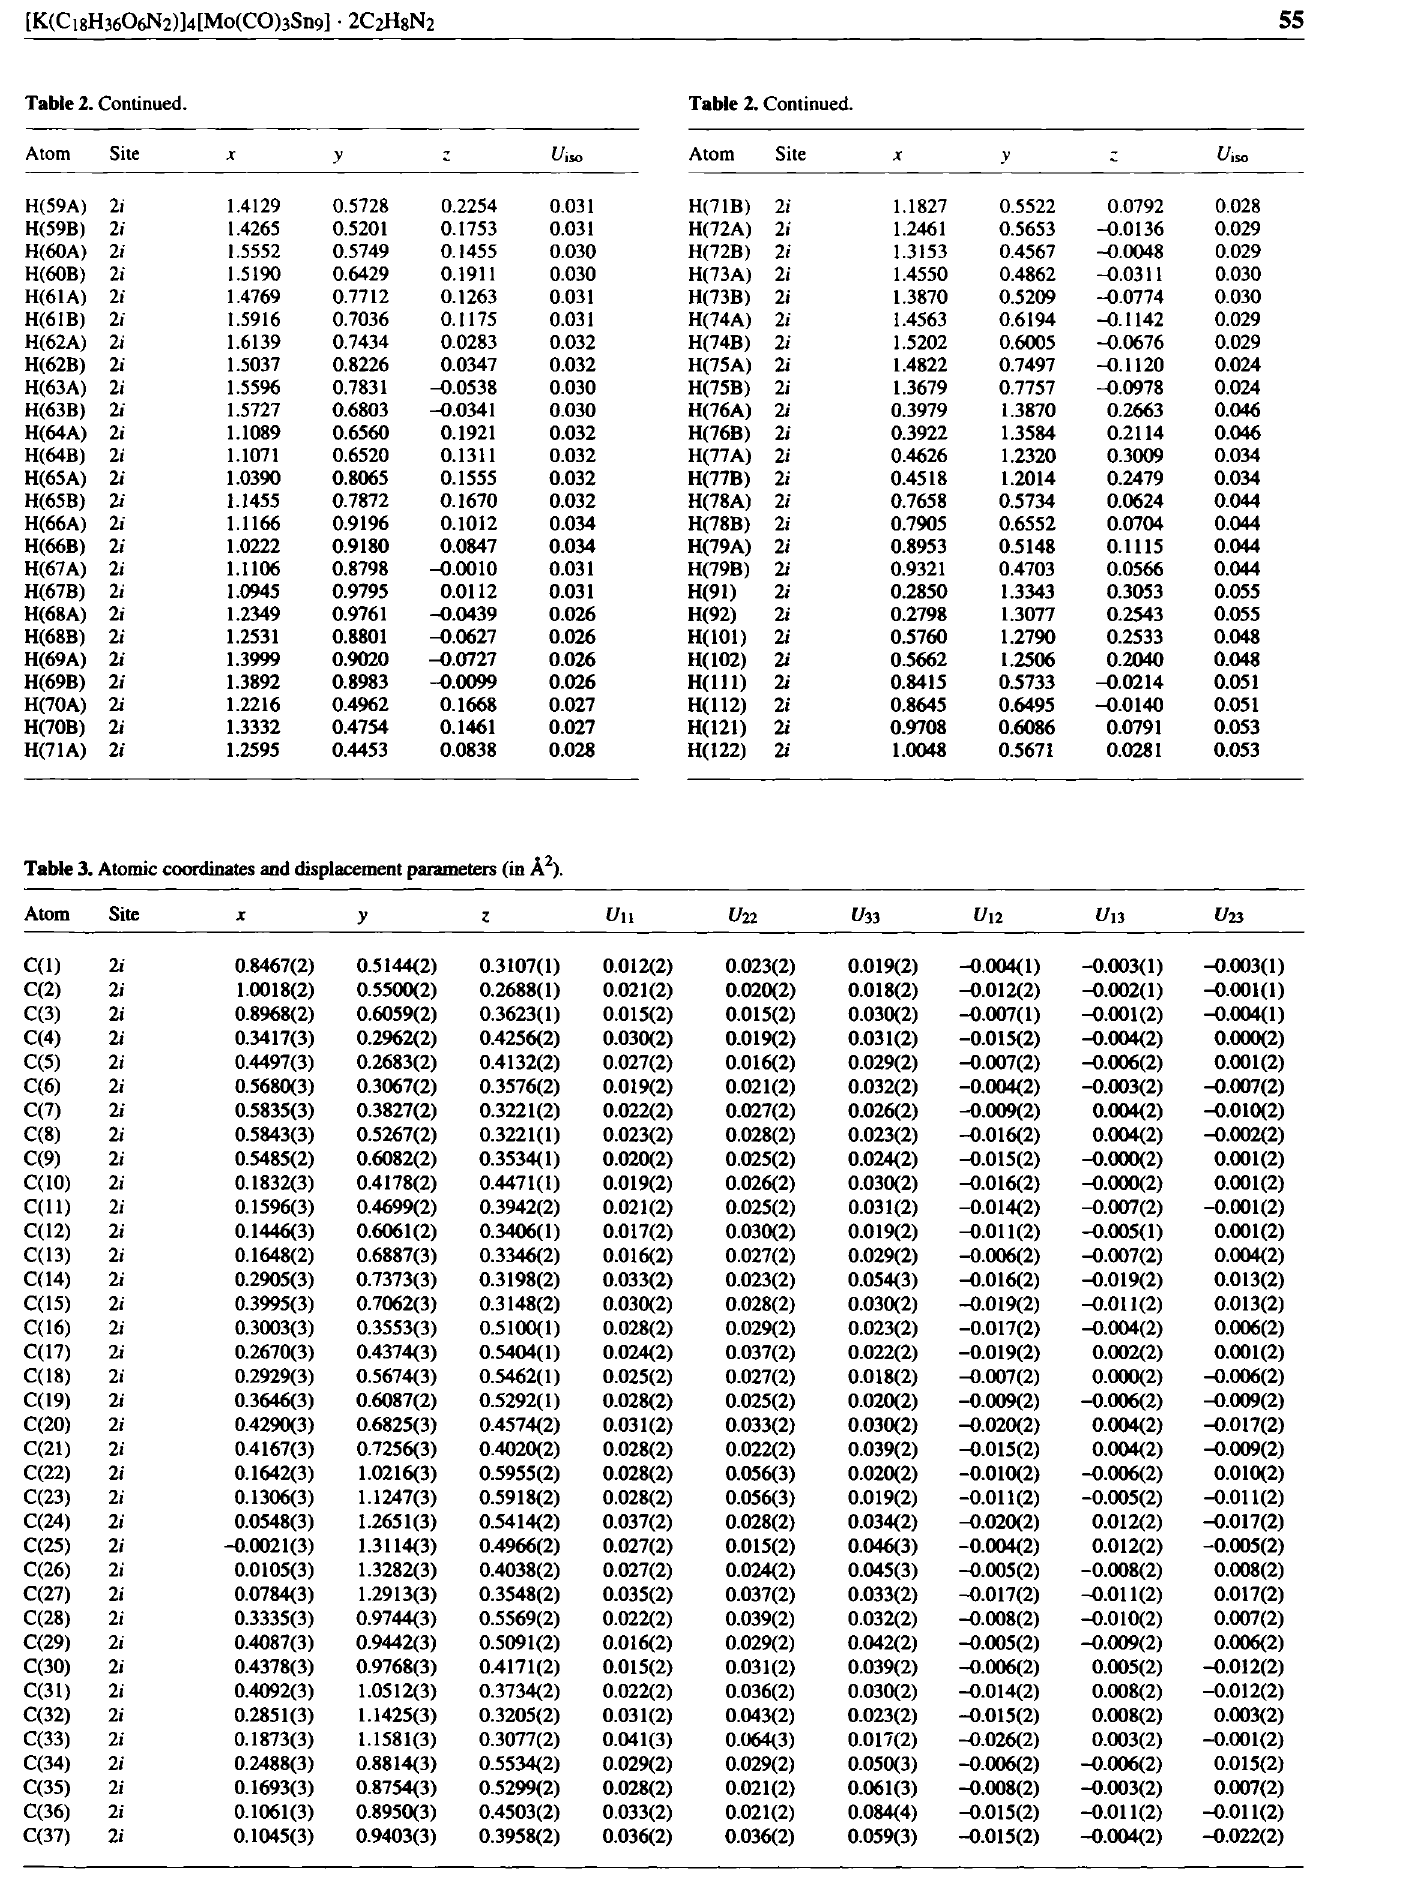
Table 3. Atomic coordinates and displacement parameters (in A 2